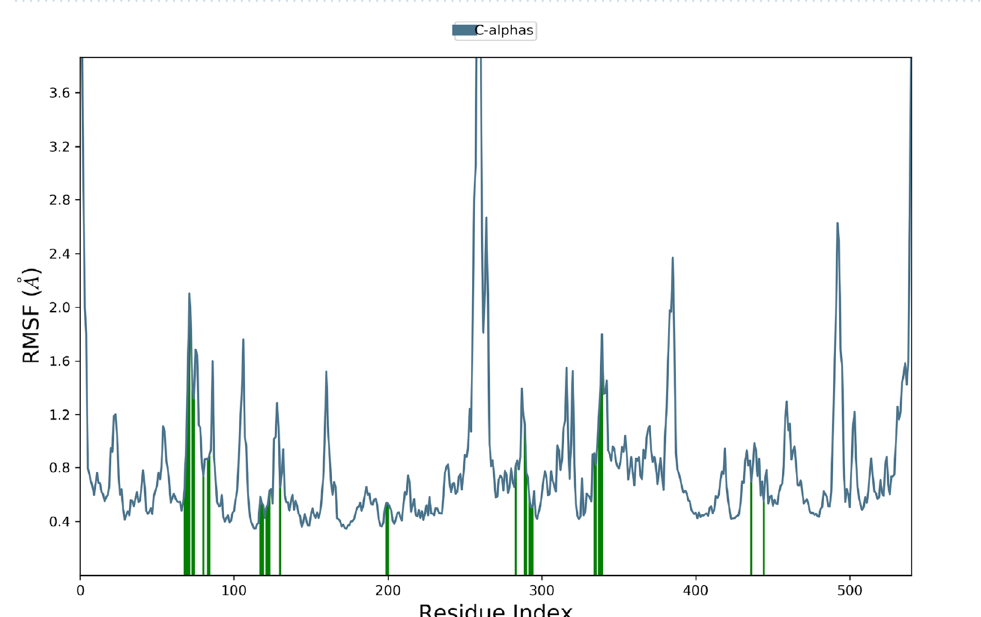
Figure 12. RMSF plot of the AChE residues in complexed with 4ad